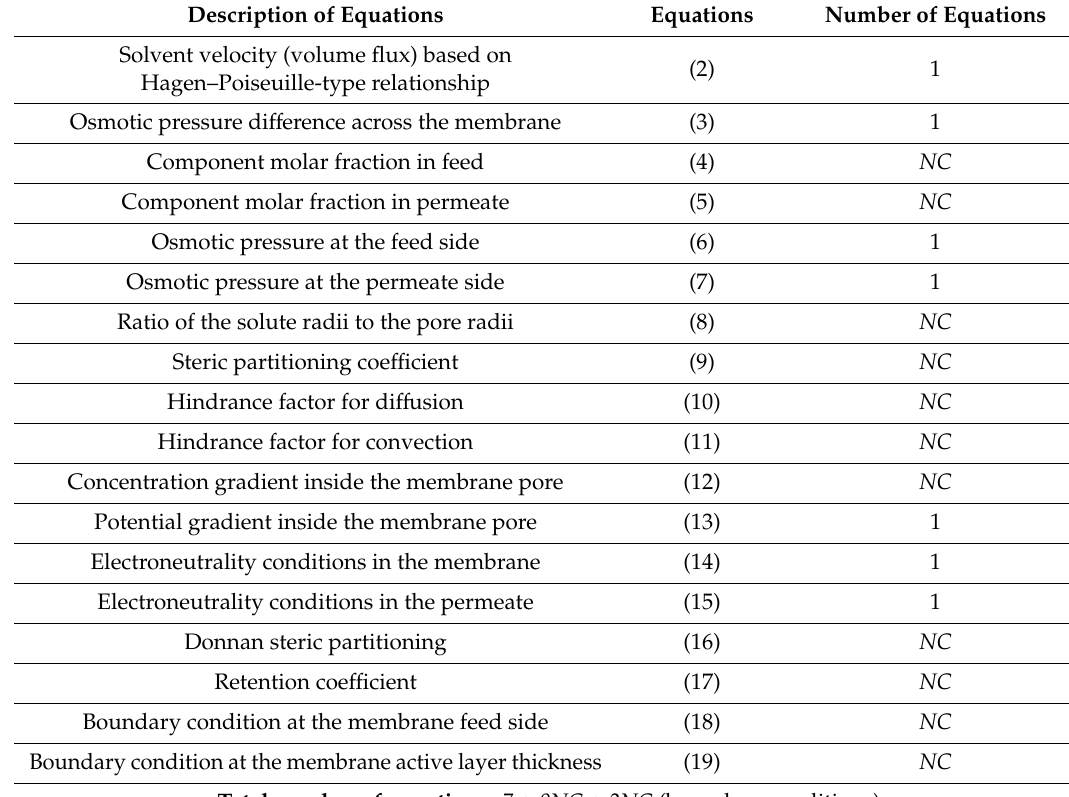
Table 3. List of equations in the ddDSPM model ( NC —number of separated